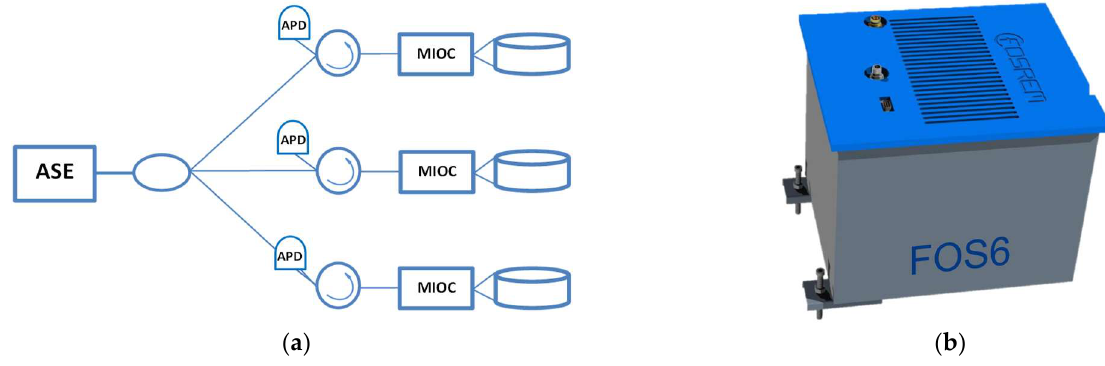
Figure 2. The basic schema of FOS6: ( a ) optical part, ( b ) system’s